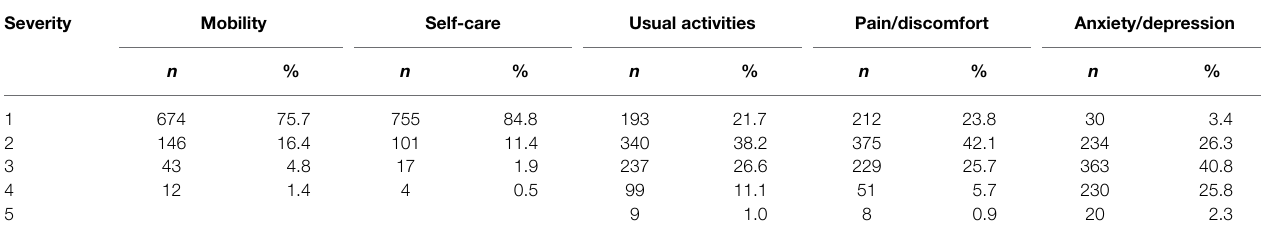
TABLE 2 | Distribution of all recorded EQ-5D responses in the patient sample ( N = 890).